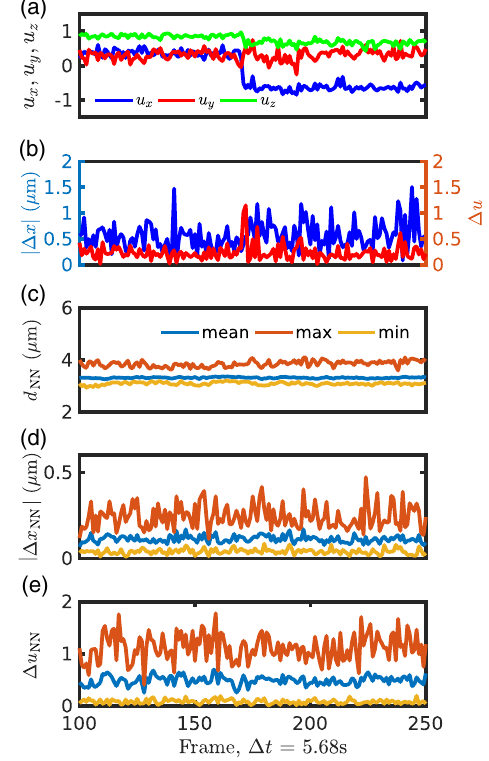
FIG. 9. Intermittent dynamics and neighboring particles. (a) x , y , and z components of the unit orientation vector of a particle undergoing stick-slip rotational motion as a function of time. All data below refer to the same trajectory. (b) Movement of the same particle over two frames, both translational Δ x and orientational Δ u displacements. (c) Distance to nearest neighbors d function of time. (d) Displacements of nearest neighbors over two frames as a function of time. (e) Displacements in orientation Δ u of nearest neighbors over two frames as a function of time. (c – e) show the mean, maximum and minimum for each